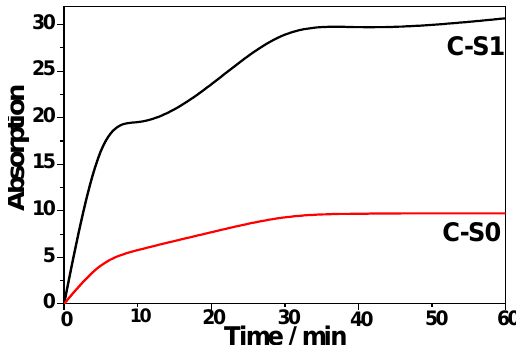
Figure 8. The adsorption rates of methylene blue (MB) on the different samples of C-S0 and C-S1. Table 1. S BET , total pore volume for C-S1, C-S2, C-S3, C-S4, and